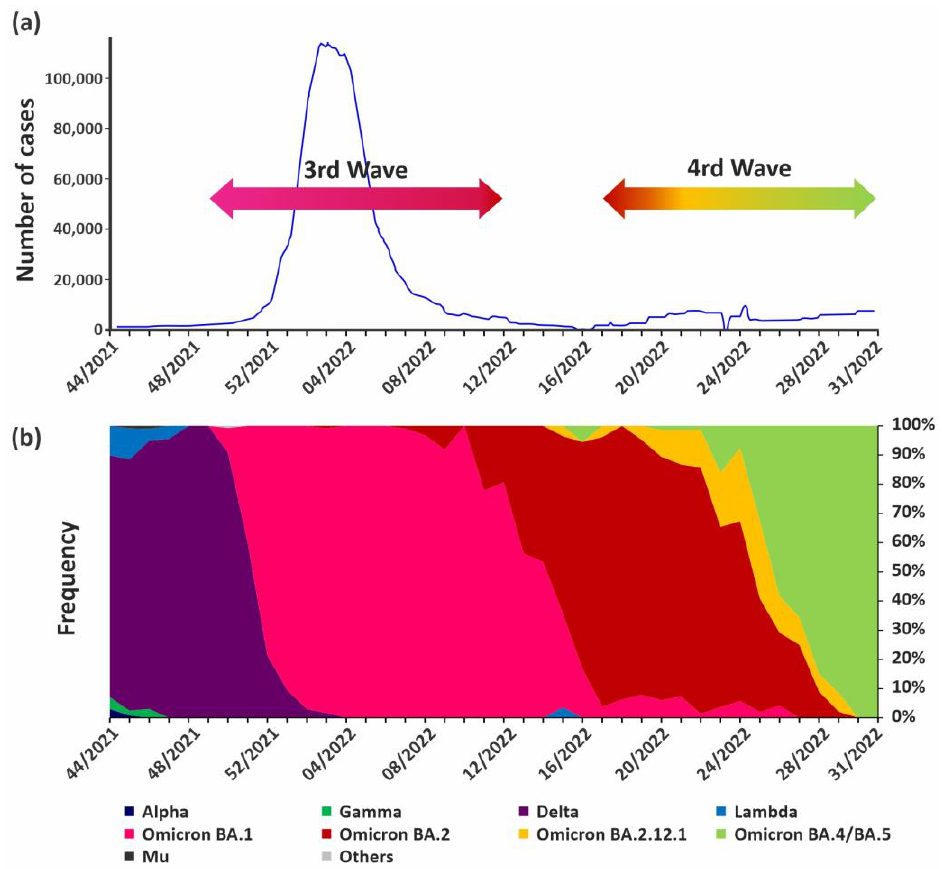
Figure 2. ( a ) Number of cases reported in Argentina from EW44/2021 to EW31/2022. Note that in EW15/2022 (between the third and the fourth waves), Argentina modified the COVID-19 massive testing criterion and since then, testing in public hospitals is only performed in populations under a higher risk for severe disease (>50 years or comorbidities). Data from https://ourworldindata.org/coronavirus#explore-the-global-situation, accessed on 1 December 2023. The arrows are colored according to the variant present at each moment of the wave. ( b ) Frequency of variant detection analyzed by epidemiological week, 2021–2022. Data from Spike and complete genome sequencing of samples from cases that did not present epidemiological link with travel (n = 3431).